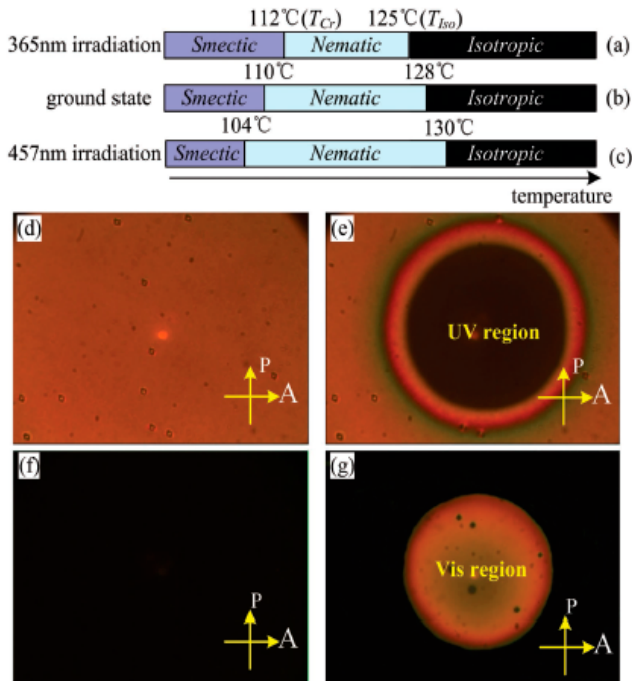
Figure 23. Phase transition of compound 41 ( a ) under UV light ( λ = 365 nm) illumination, ( b ) without illumination, ( c ) under visible light illumination ( λ = 457 nm), POM micrograph of ( d ) the nematic phase at T = 125 °C without the light exposure, ( e ) the nematic-to-isotopic isothermal transition at T = 125 °C upon UV light ( λ = 365 nm) illumination for 2 s, ( f ) the isotopic phase at T = 129 °C without the light illumination, ( g ) the isotopic-to-nematic isothermal transition at T = 129 °C upon visible light ( λ = 457 nm) illumination for 120 s. Once the illumination of visible light ( λ = 457 nm) is off, compound 41 took 3 s to restore to isotopic phase. (Reproduced with permission from ref. [119], copyright John Wiley and Sons 2019, https://doi.org/10.1002/adom.201801790).